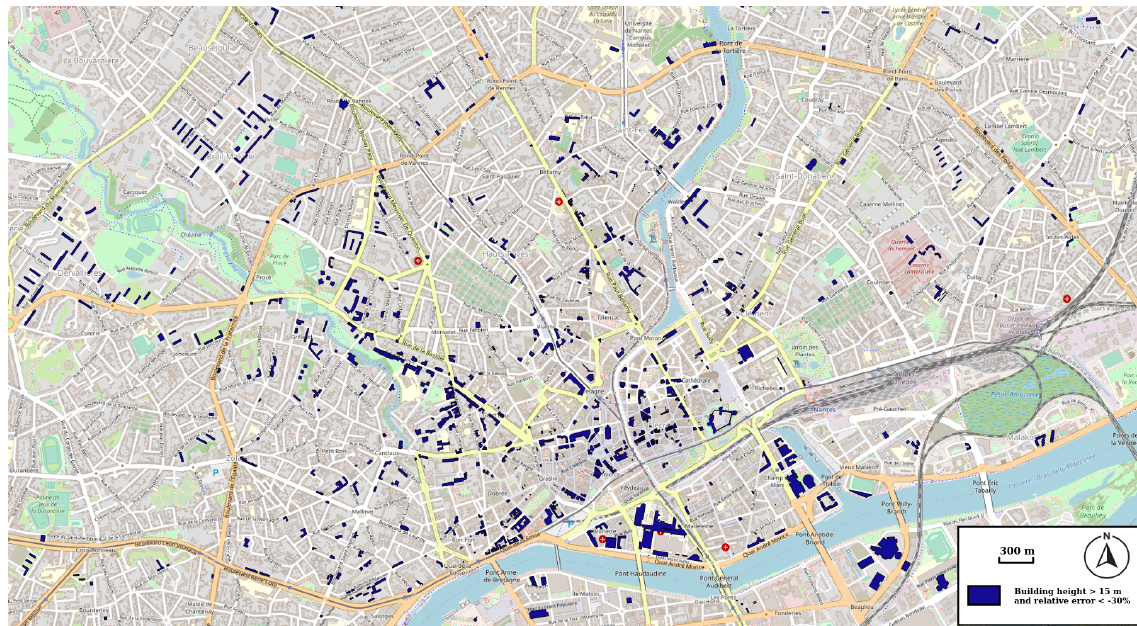
Figure 8. Buildings taller than 15m for which the height underestimation is higher than 30%. © OpenStreetMap contributors 2021. Dis- tributed under the Open Data Commons Open Database License (ODbL)